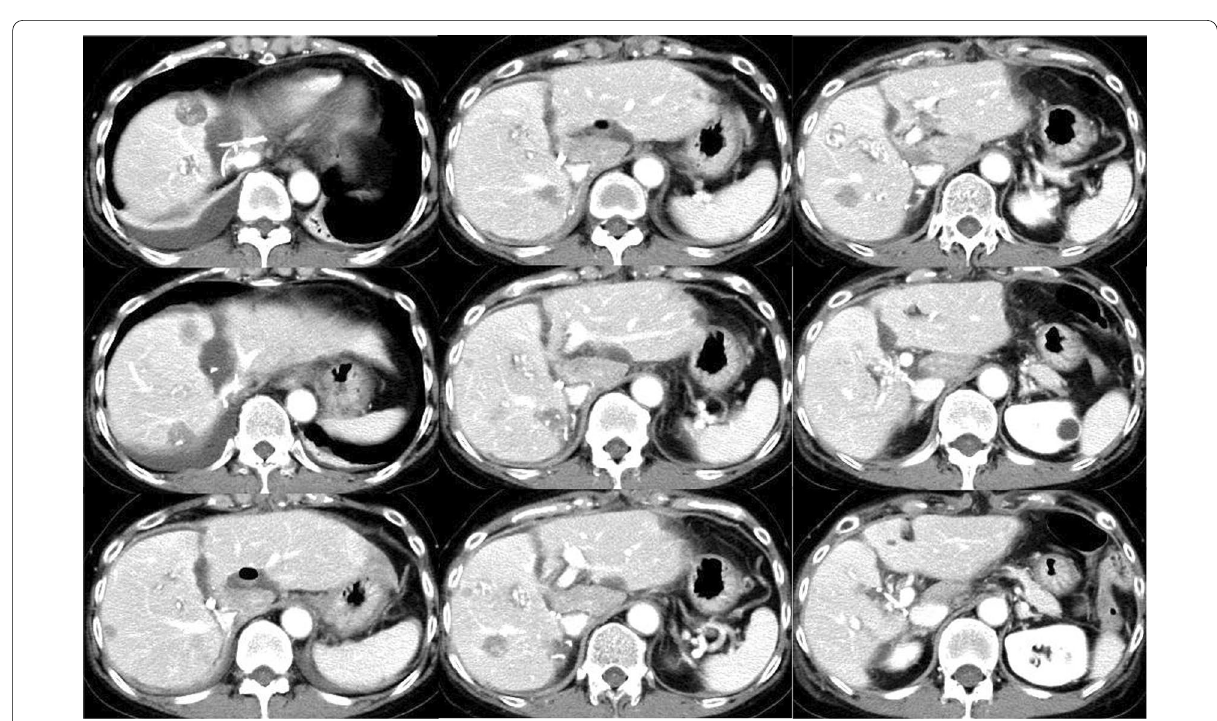
Fig. 5 Computed tomographic findings preceding stage 2 of ALPPS. No ischemia or congestion is evident, although blood supply appears slightly decreased within the left caudate